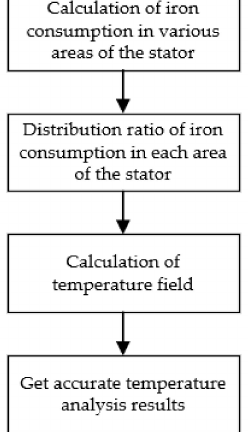
Figure 12. Flow diagram of motor iron loss-temperature field